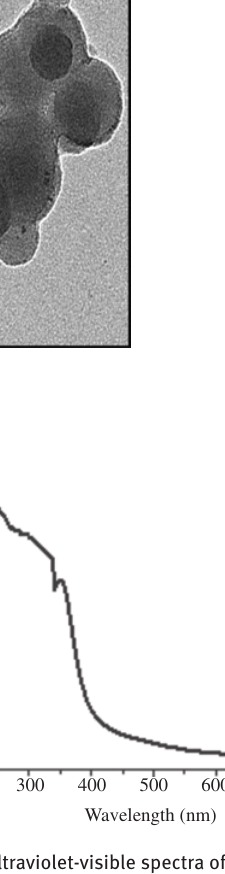
The FT-IR spectra of iron oxide NPs are given in Figure 7. The spectra of iron oxide NPs are composed of stretching mode of aromatic C-H at 3196 cm −1 , bending vibration of H-C-H at 1315 and 1410 cm −1 , C-O and C-C stretching in the range of 1000–1245 cm −1 , and out of